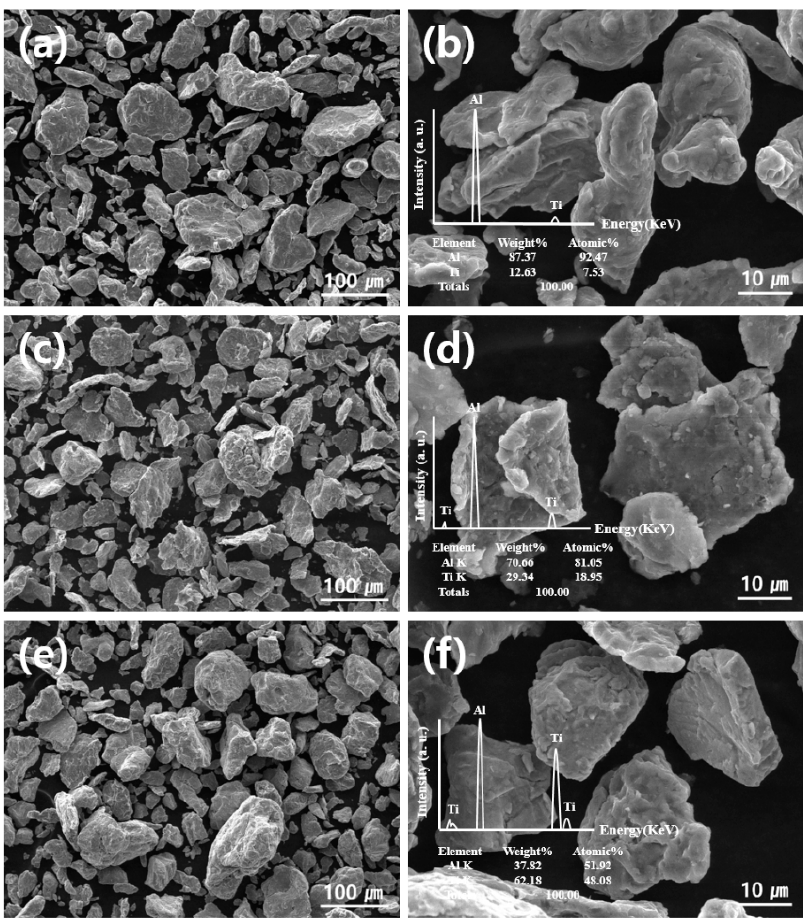
Figure 3. SEM images and EDS spectra of ( a ) and ( b ) Al-20 vol.% Ti powder, ( c ) and ( d ) Al-50 vol.% Ti powder, and ( e ) and ( f ) Al-80 vol.% Ti powder.